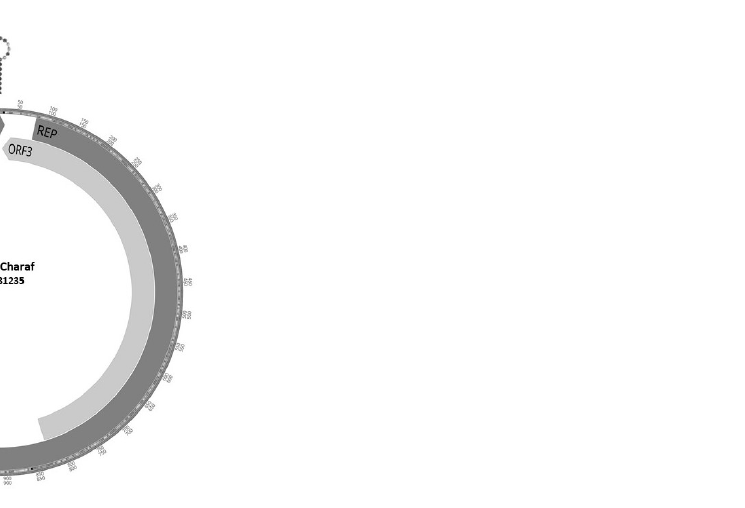
Figure 1. ORF map of EqCV1 showing location and sequence of origin of replication and of three major ORFs. The Rep protein was 327 amino acids long, sharing aa-identities of 74% with elk circovirus (Genbank MN585201) followed by PCV2 (GenBank EU148505.1) with 73% identity. The 231 amino acid long capsid protein was also closest to elk circovirus capsid (63%) (GenBank MN585201.1) followed by PCV1 (GenBank NP_065679.1) with 61.7%, PCV2 (GenBank NP_937957) (60.2%), and bat associated circovirus 2 (GenBank YP_007974238) with 48% identity. A third major ORF of a 274 amino acid protein was also identified located antisense over the rep ORF. Its closest known relative is the ORF3 from PCV2 (GenBank YP_006355434.1) at 54% identity over 38% of protein. This protein found in PCV1 (204 amino acids) and PCV2 (104 amino acids) is believed to trigger apoptotic activity in infected cells [39]. The Rep contained all three expected rolling circle replication motifs I (VFTLNN), II (PHLQG) and III (YCGK) [40]. The C-terminal region possessed the ATP-dependent helicase Walker A (GPPGCGKS), Walker B (VLDDY) and Walker C (ITSN) [40] motifs. The origin of replication stem loop had a 14 base pairs stem and a 12 base loop with a nearly canonical (TAGTATTAC) sequence (AAGTATTAC) [40]. Phylogenetic analyses were then performed showing that the EqCV1 rep and cap proteins clustered with PCV1/2, as well as elk and bat 2 (insectivorous Rhinolophus fer- rumequinum or greater horseshoe bat) circoviruses (Figure 2).